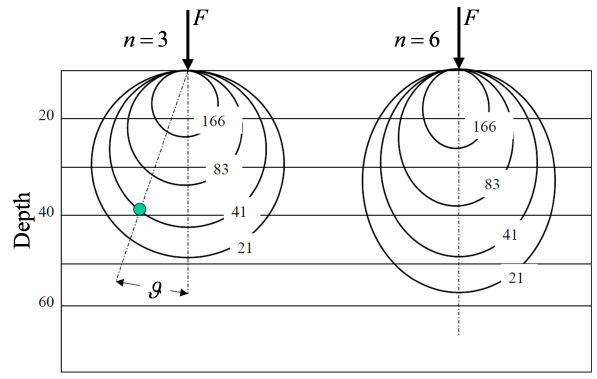
Figure 8: Fröhlich’s curves of equal vertical normal stress in the elastic medium (from [6]).